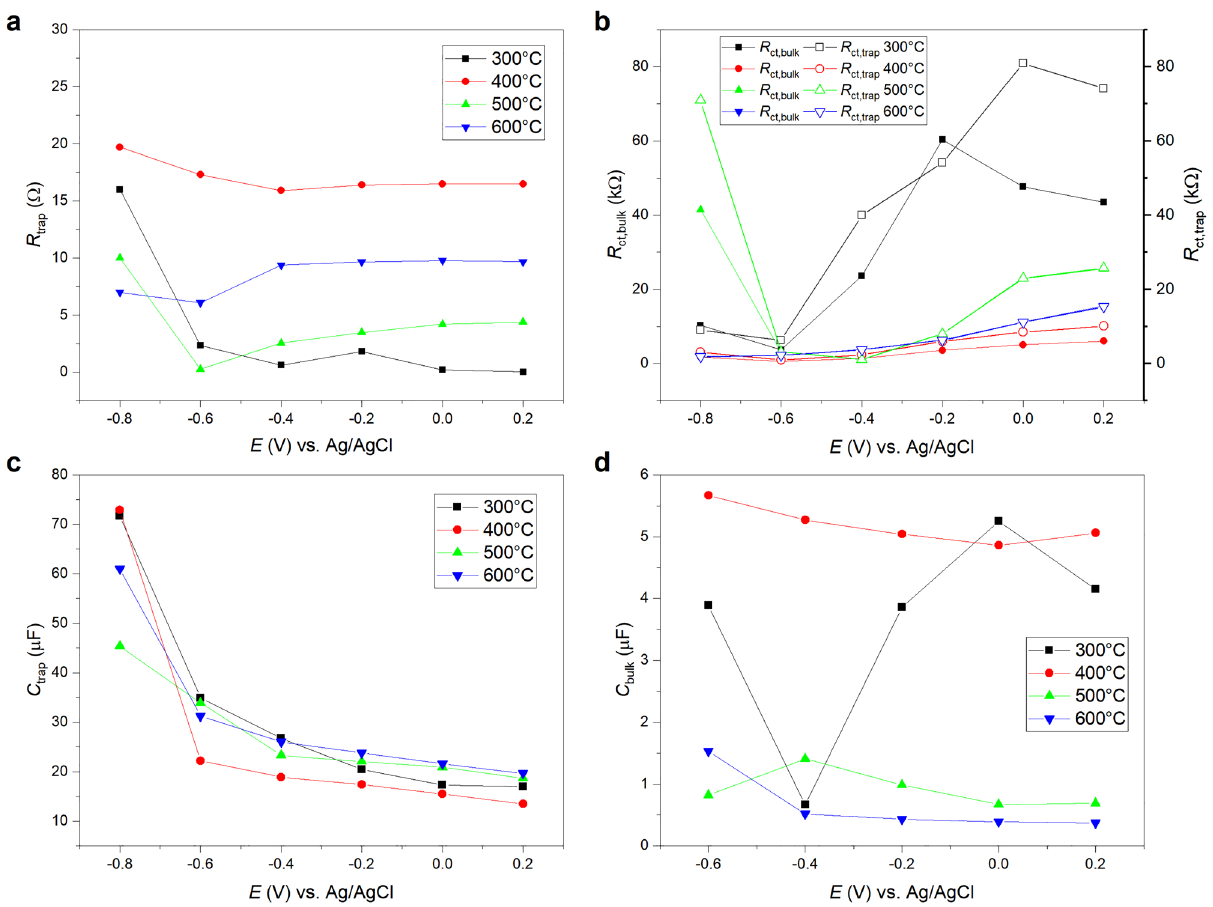
Figure 8. ( a – d ) Equivalent circuit element parameters extracted by fitting the PEIS data of TiO 2 nanolayers from Fig. S6 with the equivalent circuit shown in Fig. 1c in dependence on the applied potential. The drawn lines serve as guide to the